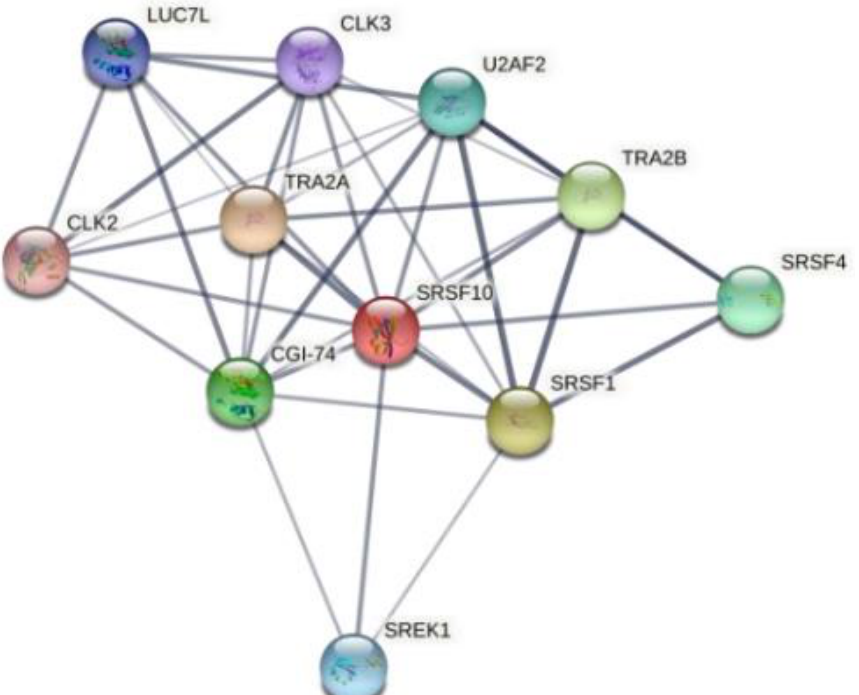
Figure 7. Human SFRS10 interactome network generated using STRING 11.5 database. It contains 11 nodes (proteins), with 38 edges (interactions) between them. The network shows serine/arginine-rich splicing factor, kinases, and transformer proteins.